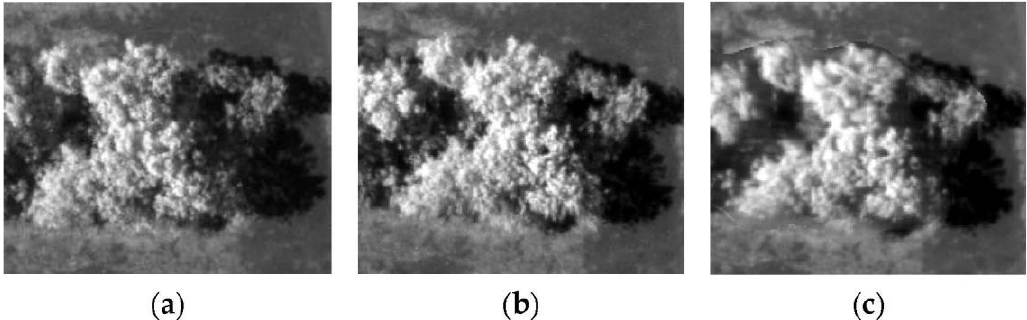
Figure 3. The appearance of the same avocado tree between ( a ) an original image; and the orthomosaics derived from ( b ) Agisoft PhotoScan and ( c ) Pix4DMapper. Although the avocado tree looks similar in ( a – c ), the halo effect surrounding the tree in ( c ) is visible.